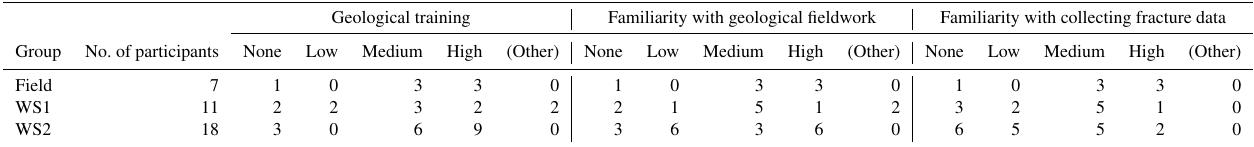
Table 3. Summary of the level of geological training, and experience in geological fieldwork and fracture data collection, reported by field and workshop (WS) participants. Individual participant responses are provided in the Supplement